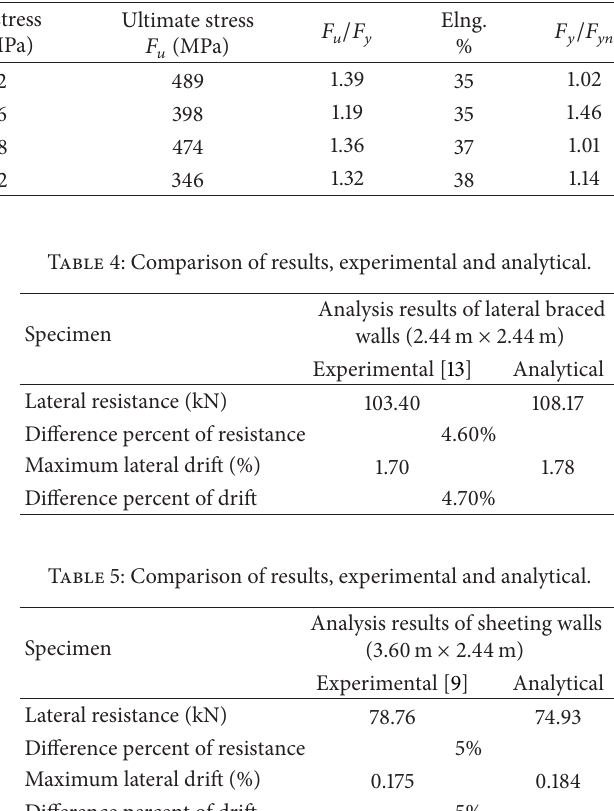
Table 3: Matrix of strap-braced wall tests (nominal design dimensions and material properties).